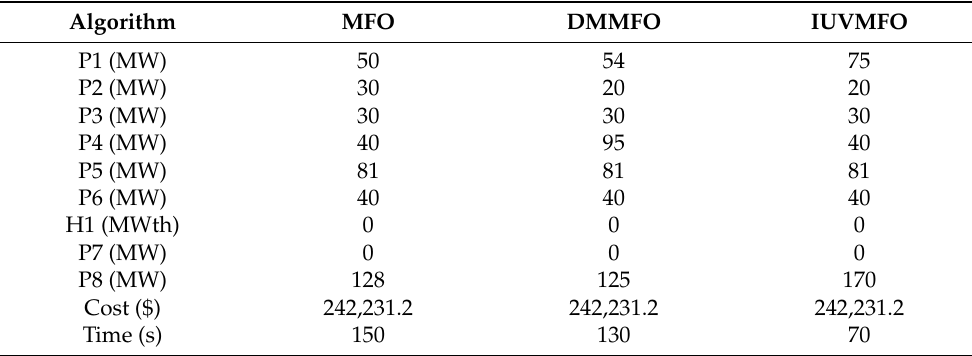
Table 11. Comparison of results for economic dispatch of